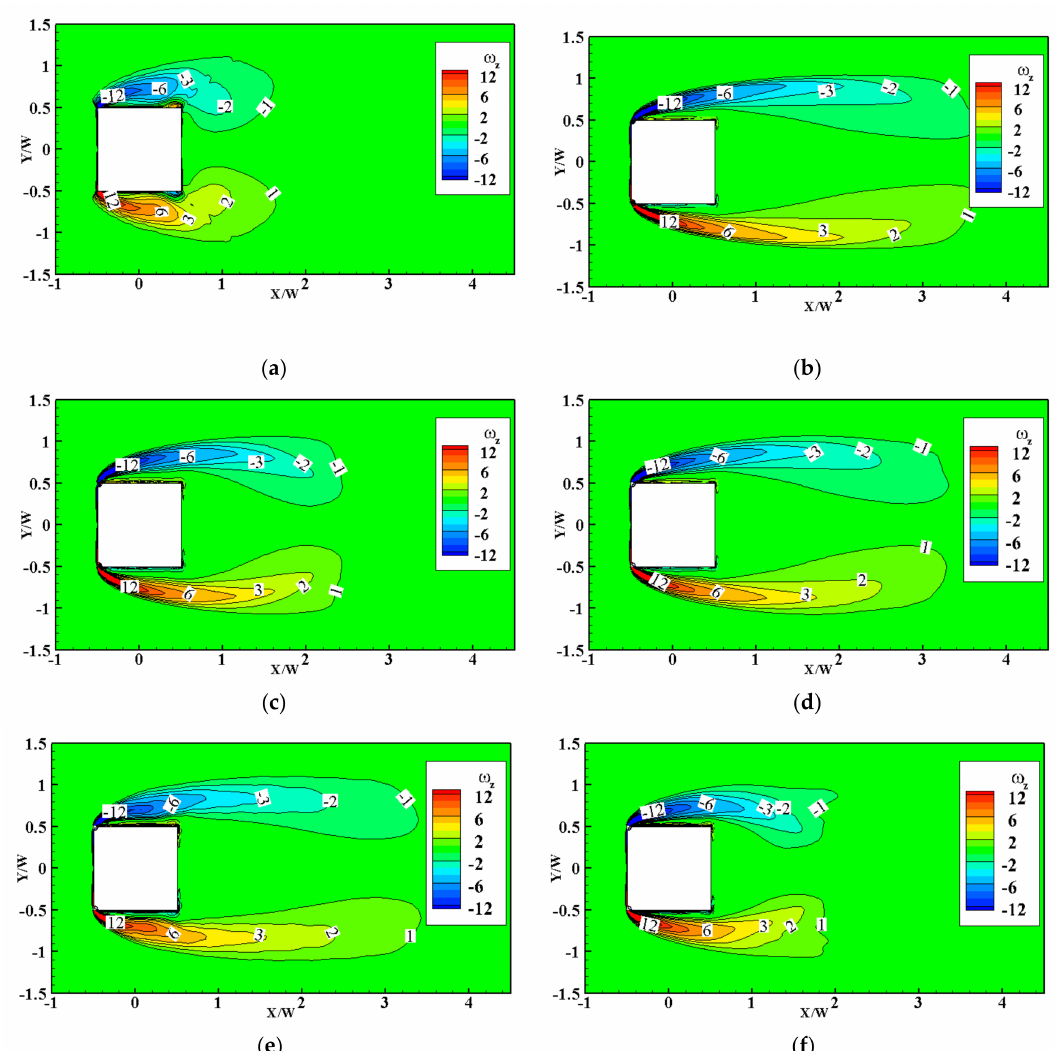
Figure 14. Normalized time-averaged vorticity distributions: ( a ) plain cylinder; ( b ) S2 ; ( c ) S4 ; ( d ) R1 ; ( e ) R6 ; ( f ) R8